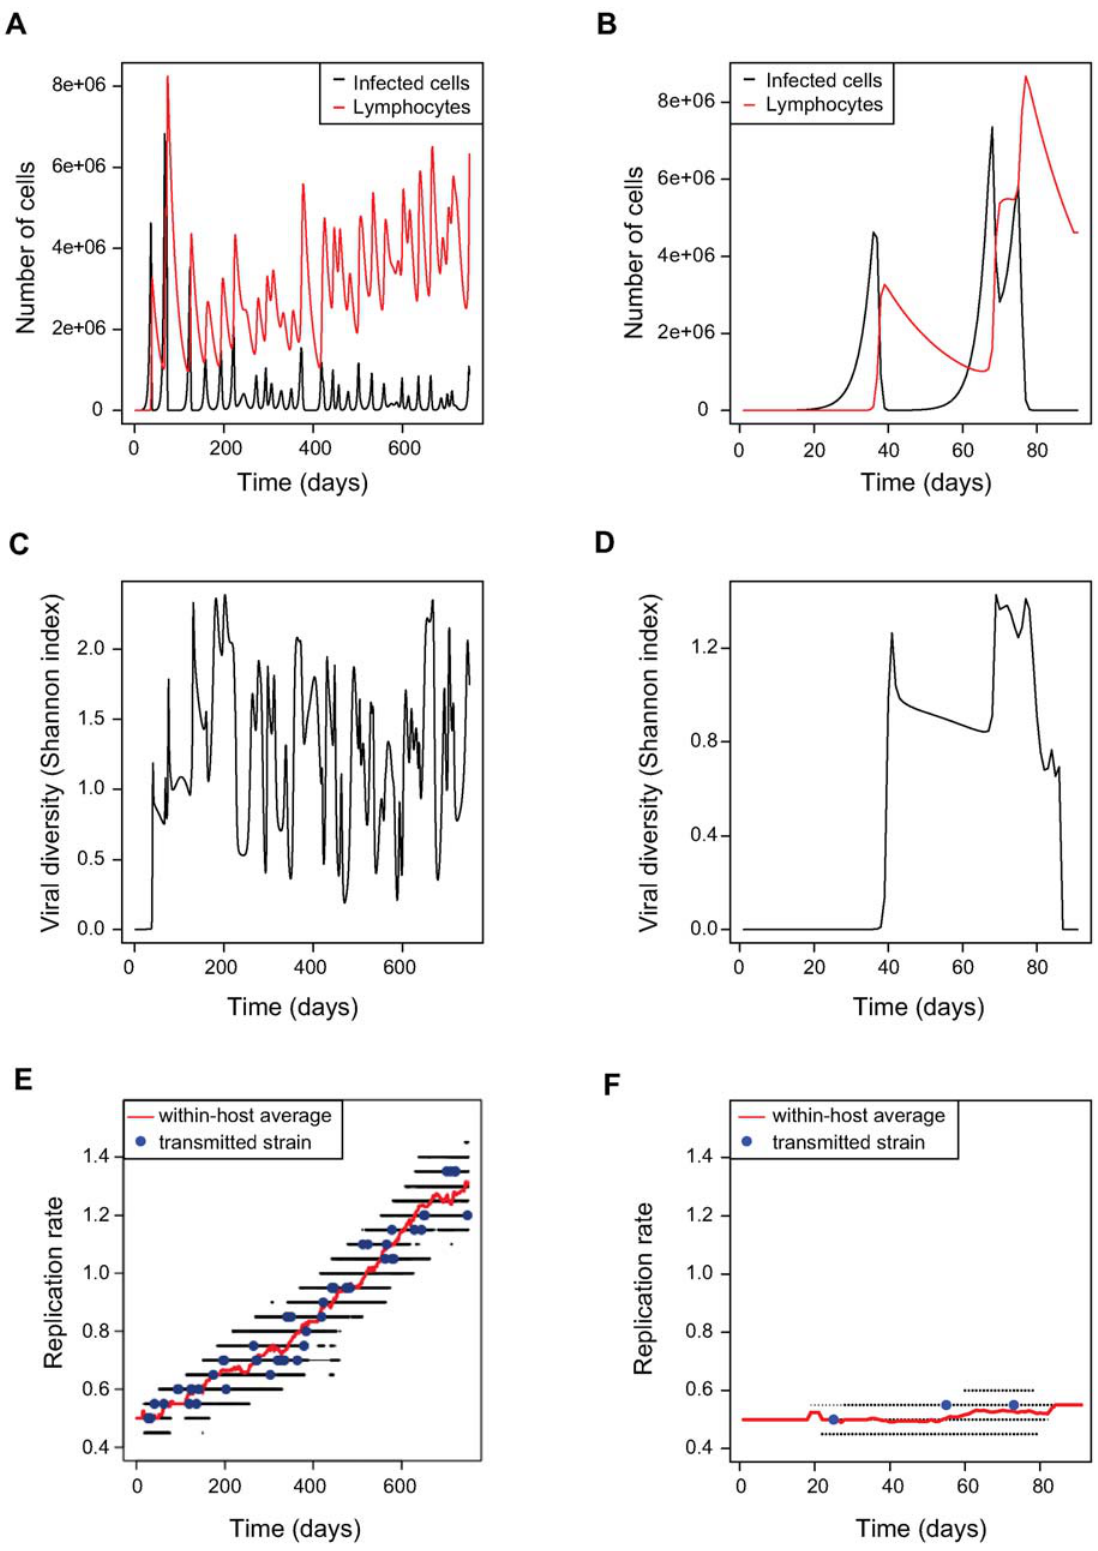
Figure 1. Within-host population dynamics and evolutionary dynamics for two ‘‘typical’’ simulation runs. With identical parameter values, we can observe a chronic (A,C,E) or an acute (B, D, F) infection. A) and B) Population dynamics of infected cells (in black) and immune cells (in red). C) and D) Diversity dynamics (Shannon index). E) and F) Evolutionary dynamics of the replication rate. Black dots indicate the replication rates present at any time, the red line is the average replication rate for each time t, and the large blue dots show the replication rates of the strains that are transmitted to another host after a transmission event. Here Q 0 ~ 0 : 5 . Other parameter values are default and given in Table 1.